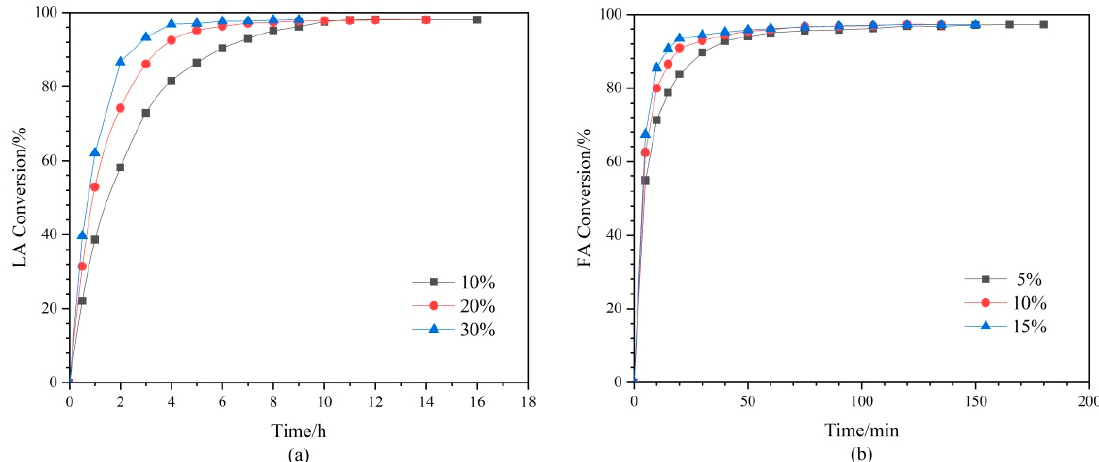
Figure 1. Kinetic data of ( a ) LA with various initial catalyst dosage at 363.15 K and ( b ) FA at 353.15 K.